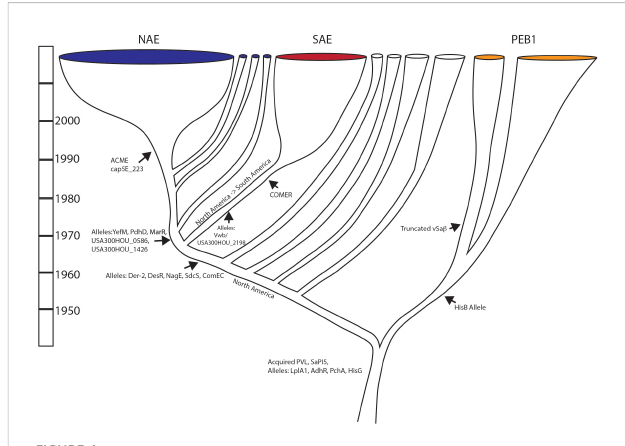
FIGURE 4 Evolutionary scenario of USA300: Summary of major evolution events of USA300 based on work presented. Major gene acquisition and allele changes are